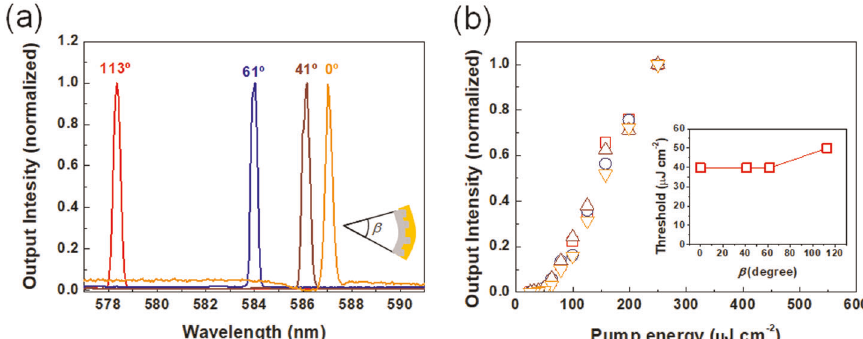
Fig. 7 a Laser emission on DFBs based on F8BT upon 113° bending (red), 61° (blue), 41° (brown), and 0° (orange). The inset sketch illustrates a DFB under a β bending angle. b Integrated emission intensity as function of pump fl uence for different bending angles: 113° (squares), 61° (circles), 41° (up-triangles), and 0° (down-triangles). Lasing thresholds as a function of bending angle are shown in the